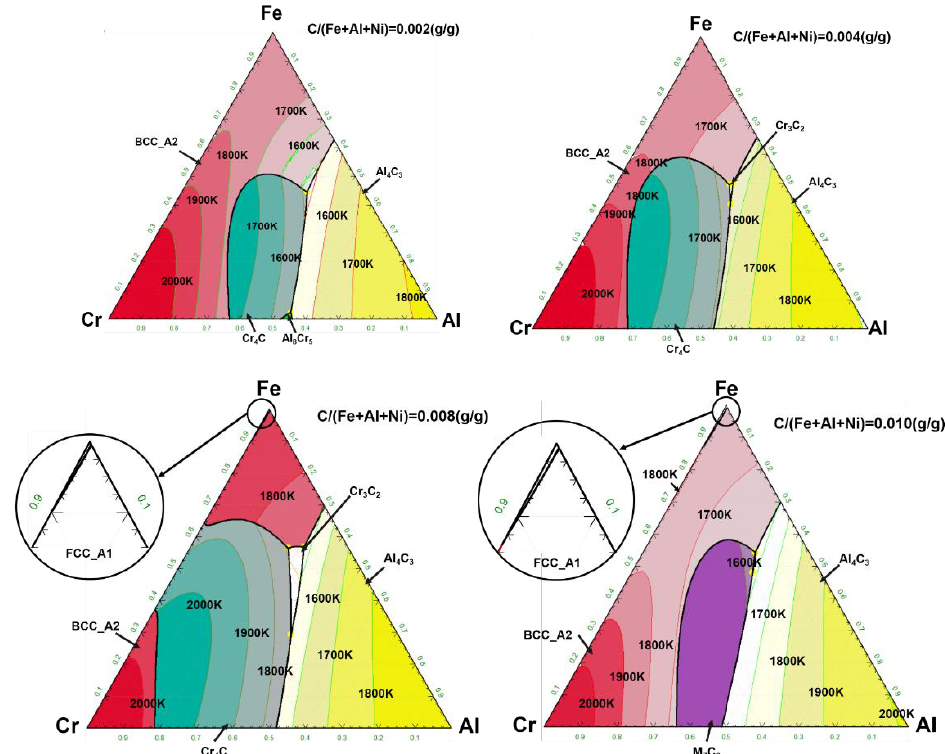
Figure 7. Effect of C addition on the Fe – Al – Cr phase diagram (1000 – 2000 K). ( a ) C/(Fe + Al + Cr) = 0.2 wt.%; ( b ) C / (F e + Al + Cr) = 0.4 wt.%; ( c ) C / (Fe + Al + Cr) = 0.8 wt.%; and ( d ) C / (Fe + Al + Cr) = 1 wt.%.